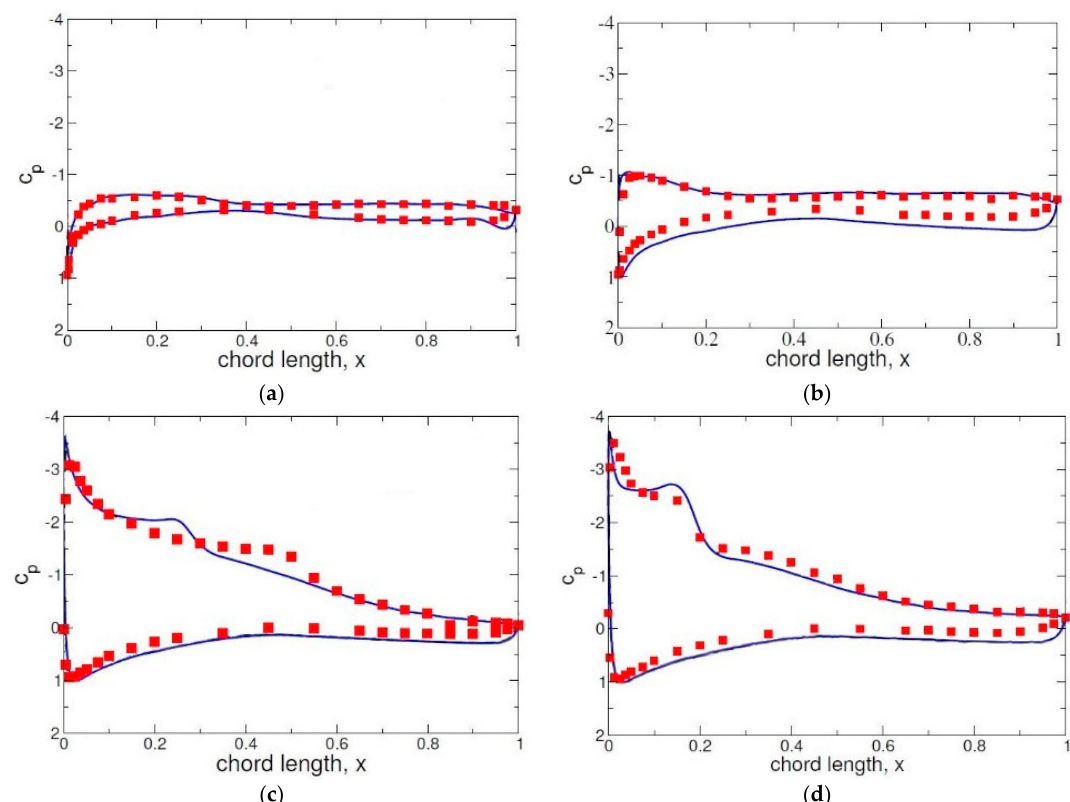
Figure 20. Computed (lines) and measured (symbols) wall pressure coefficient distributions for Re = 64,200 and ( a ) α = 4.19 degrees, ( b ) 8.64 degrees, ( c ) 11.24 degrees, and ( d ) 13.84 degrees. (Reprinted from [28]).